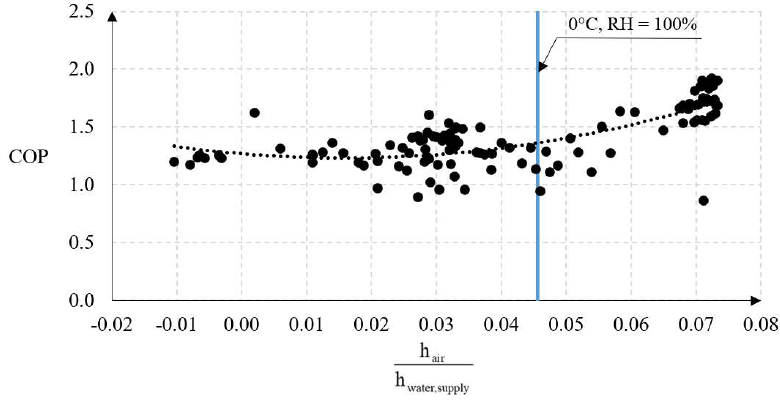
Figure 11. A comparison of all three periods—the variation in the COP depending on the ratio of enthalpies of ambient air and water supplied. enthalpies of ambient air and water